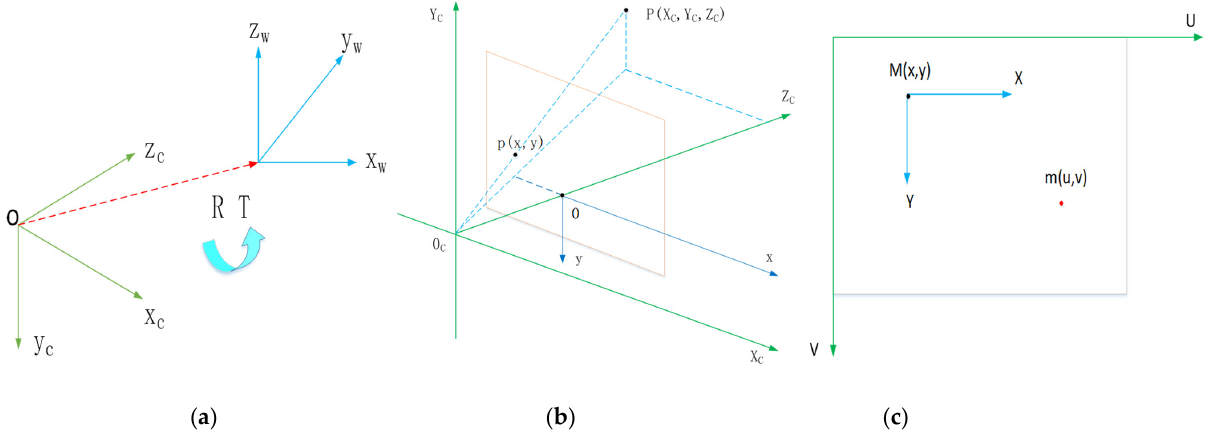
Figure 5. Coordinate system conversion relationship. ( a ) Conversion between world coordinate system and camera coordinate system; ( b ) Conversion between camera coordinate system and image coordinate system; ( c ) Conversion between image coordinate system and pixel coordinate system.